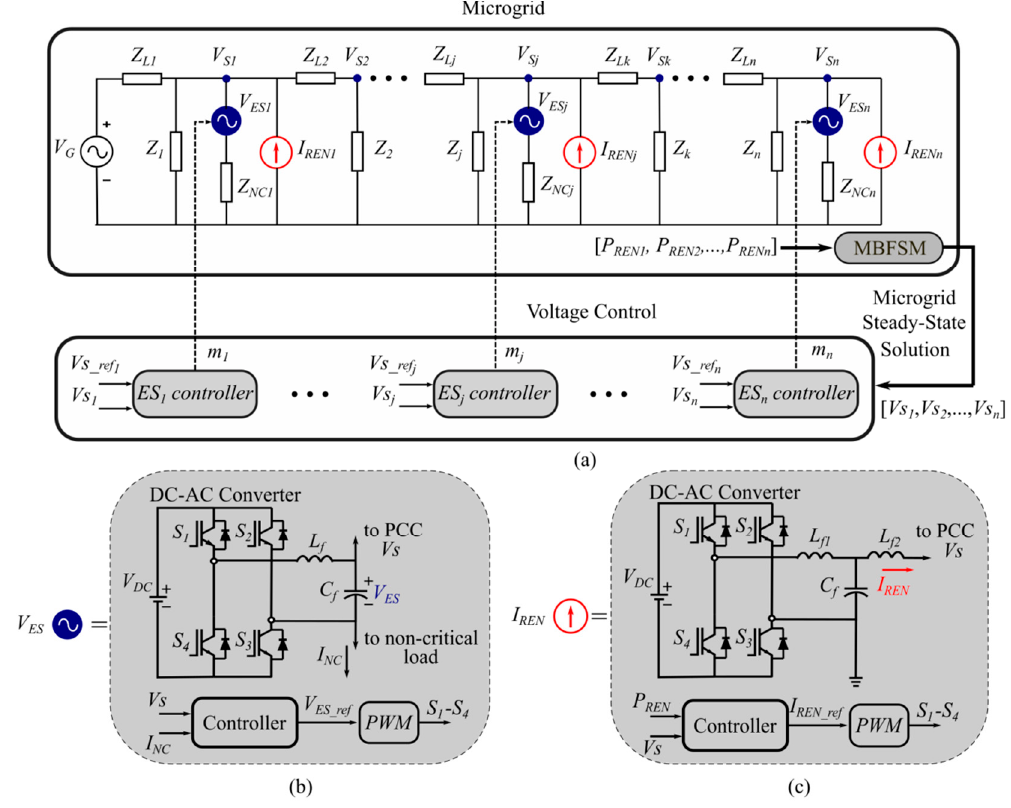
Figure 3. Simulation diagram: ( a ) micro-grids ( µ G) and algorithms, ( b ) electric spring (ES) dynamic model, and ( c ) P REN dynamic model.